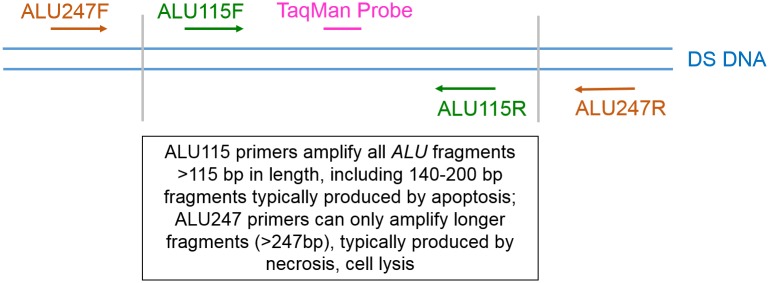
Alu 115bp (ALU115) and 247bp (ALU247) PCR primer designs.Forward and reverse primers of ALU115 are indicated by green text, ALU247 primers by orange text. Brackets indicate the size of fragments (140–200 bp) generated by enzymatic apoptotic cleavage as compared to the total length of the Alu element. ALU115 primers amplify apoptotic and longer DNA fragments, while ALU247 primers only amplify sequences longer than apoptotic DNA.